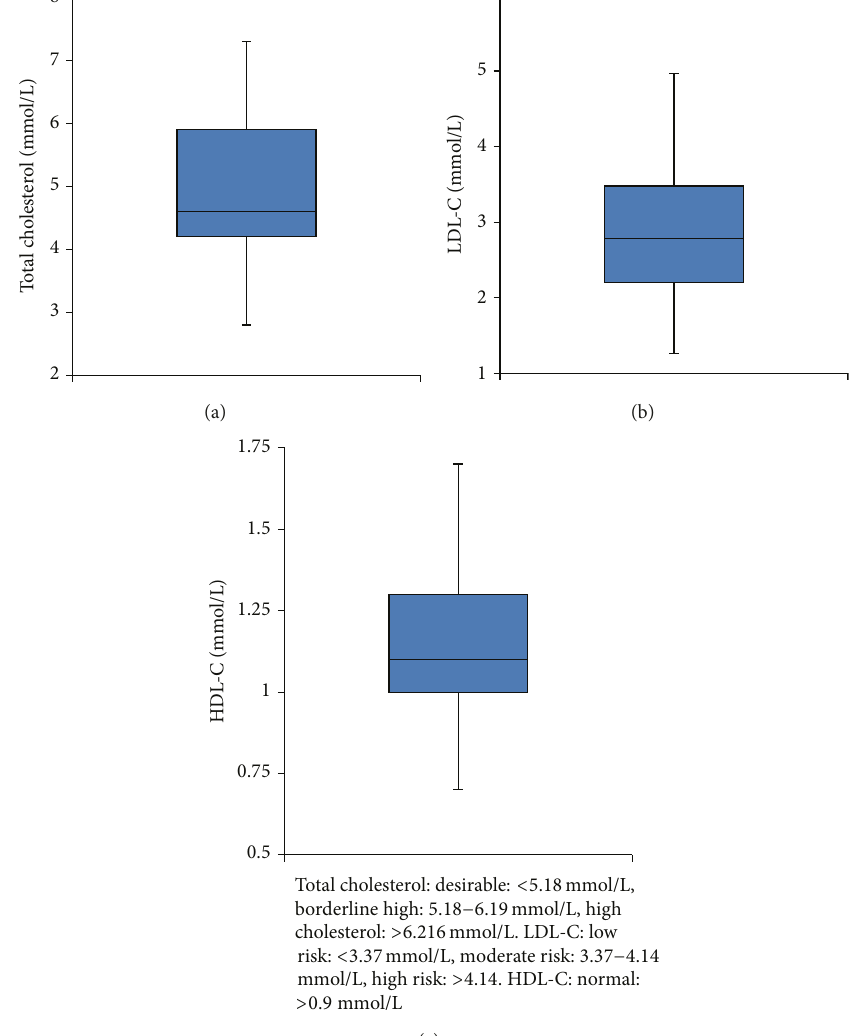
Figure 5: Lipid p rofi le data of the study group. (a) Median and interquartile ranges of total cholesterol; (b) median and interquartile ranges of low-density lipoprotein cholesterol (LDL-C); (c) median and interquartile ranges of high-density lipoprotein cholesterol